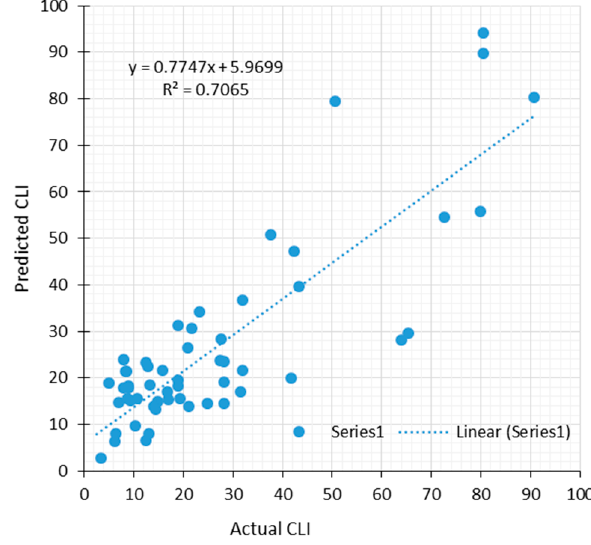
Figure 15. Relations between the actual and estimated CLI by ANN model 7 for training.